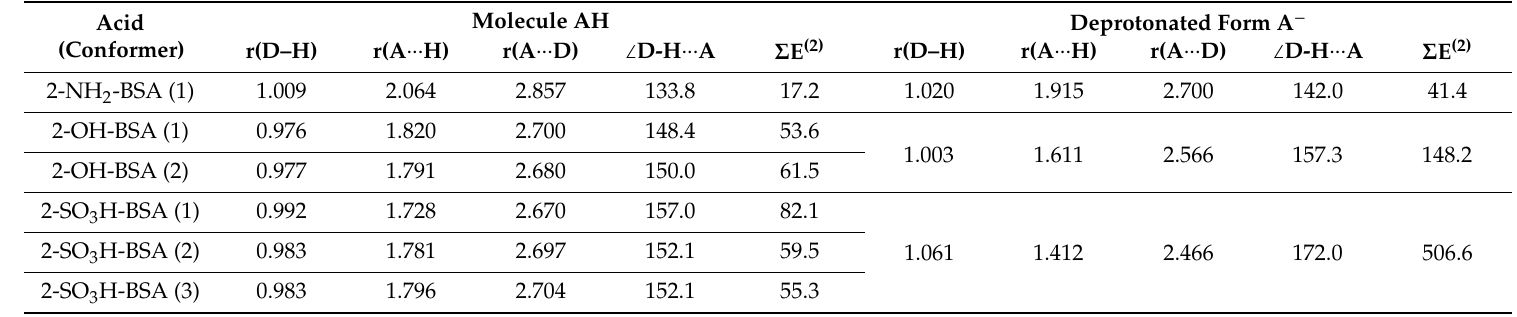
Table 2. Geometric characteristics of IHB in conformers of AH acids and deprotonated forms A − (D–IHB donor, A—IHB acceptor, interatomic distances in Å, angles